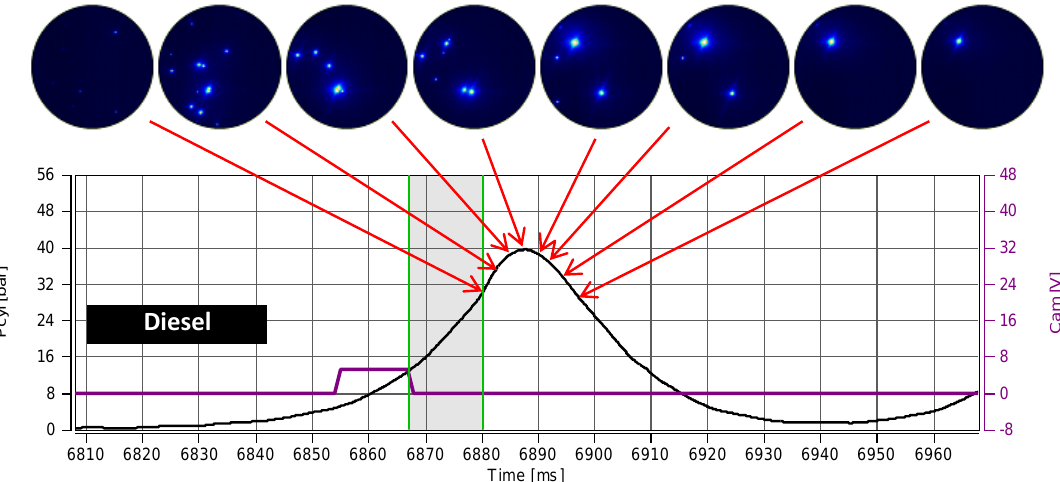
Figure 14. Location of the autoignition spots when combusting diesel oil (indicator graph) (dt for the images: 2.5 ms). The analysis of the combustion of the JET fuel started from the 90th image (the first autoignition spot appeared there). This denotes the time 90 × 0.2 ms = 18 ms from the start of the falling curve of the camera-controlling signal (Figure 15). As before, the point in time, from which the autoignition spots were analyzed, was marked with a second vertical green line. One can see an increased intensity of the autoignition spots compared to the diesel fuel. The spots were larger and of identical glow intensity.